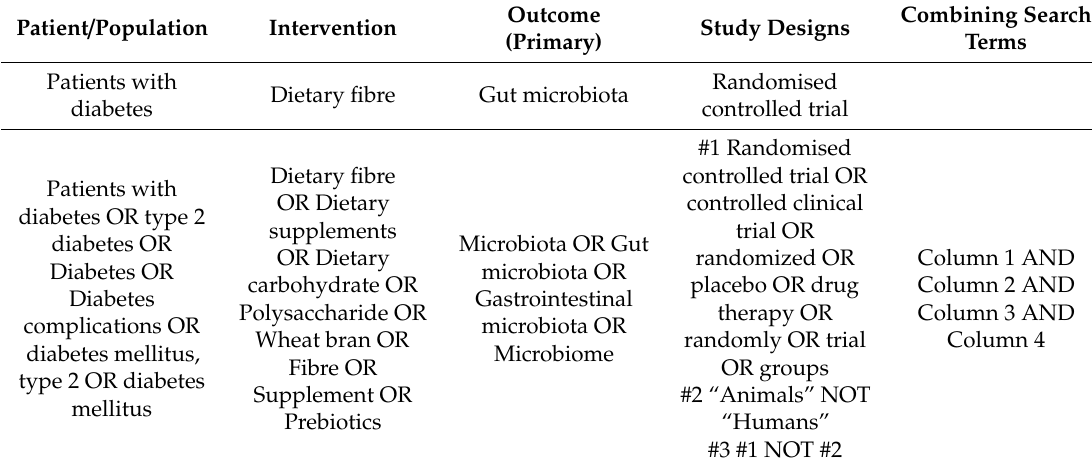
Table 1. Search Terms and Search